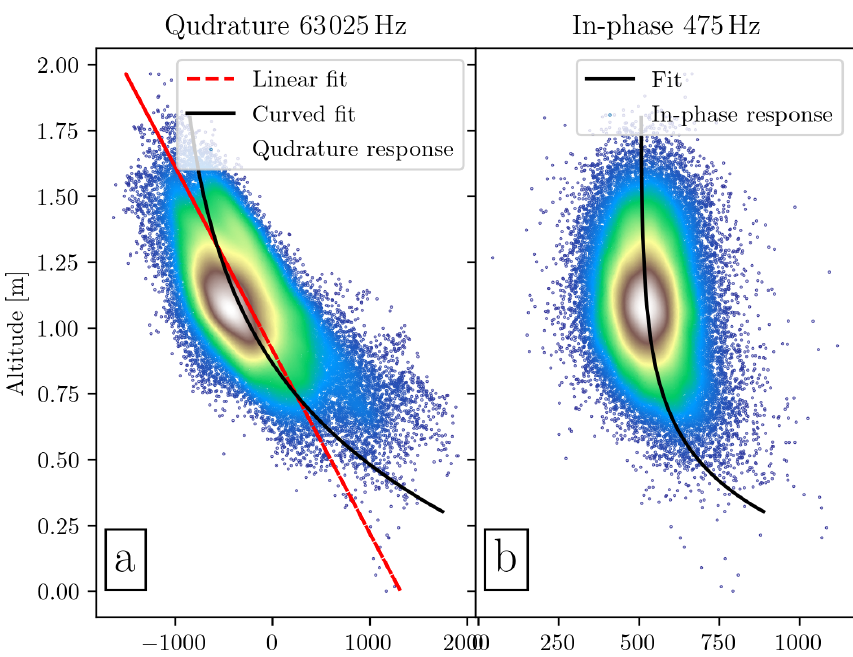
Figure 10. Parts per million versus altitude for the Falster survey data shown as a scatter-density plot. (a) Quadrature response at 63025Hz, (b) in-phase response at 475Hz. We calculated a fit on the form of a + b · exp (h · c) , represented here as the black line. The parameters a , b , and c in the fit can also be found in Table 3. We further calculated the linear fit for the quadrature response (slope of ∼ 14ppmcm − 1 , shown with the red line) in order to honour the linear correlation results of the controlled Test 3 in Fig. 5.